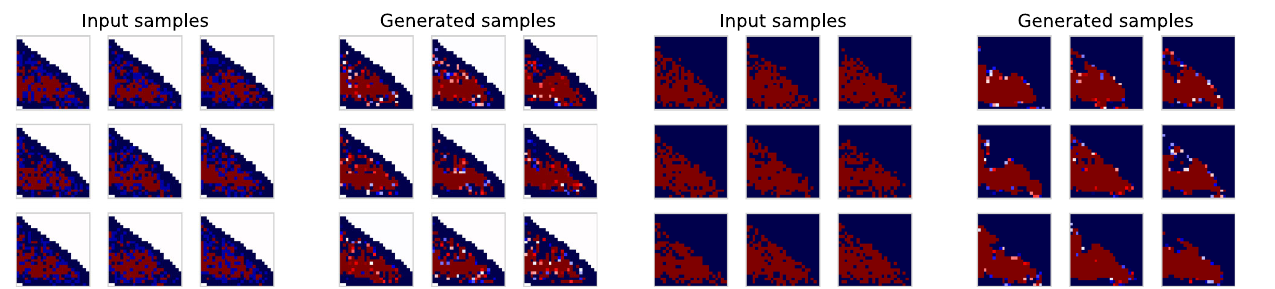
Fig. 15 A random selection of preprocessed input images (left), and of images generated with the WGAN-GP model (right). Axis and colour schemes are the same of Fig.